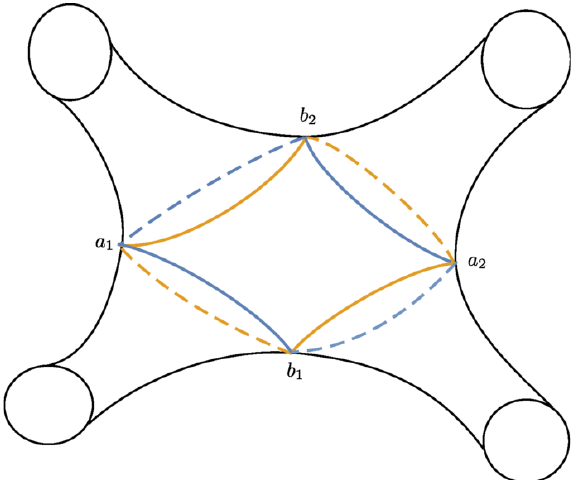
Figure 19. Rendering on the mirror curve of the two basic states on the resolved conifold. are formed by resolving intersections. In the quiver quantum mechanics, the bound states arise from tachyonic (cid:12)elds condensing and the matter (cid:12)elds acquiring a non-zero vacuum expectation value (VEV). In terms of quiver representations, this corresponds to arrows associated to resolved intersections taking non-zero